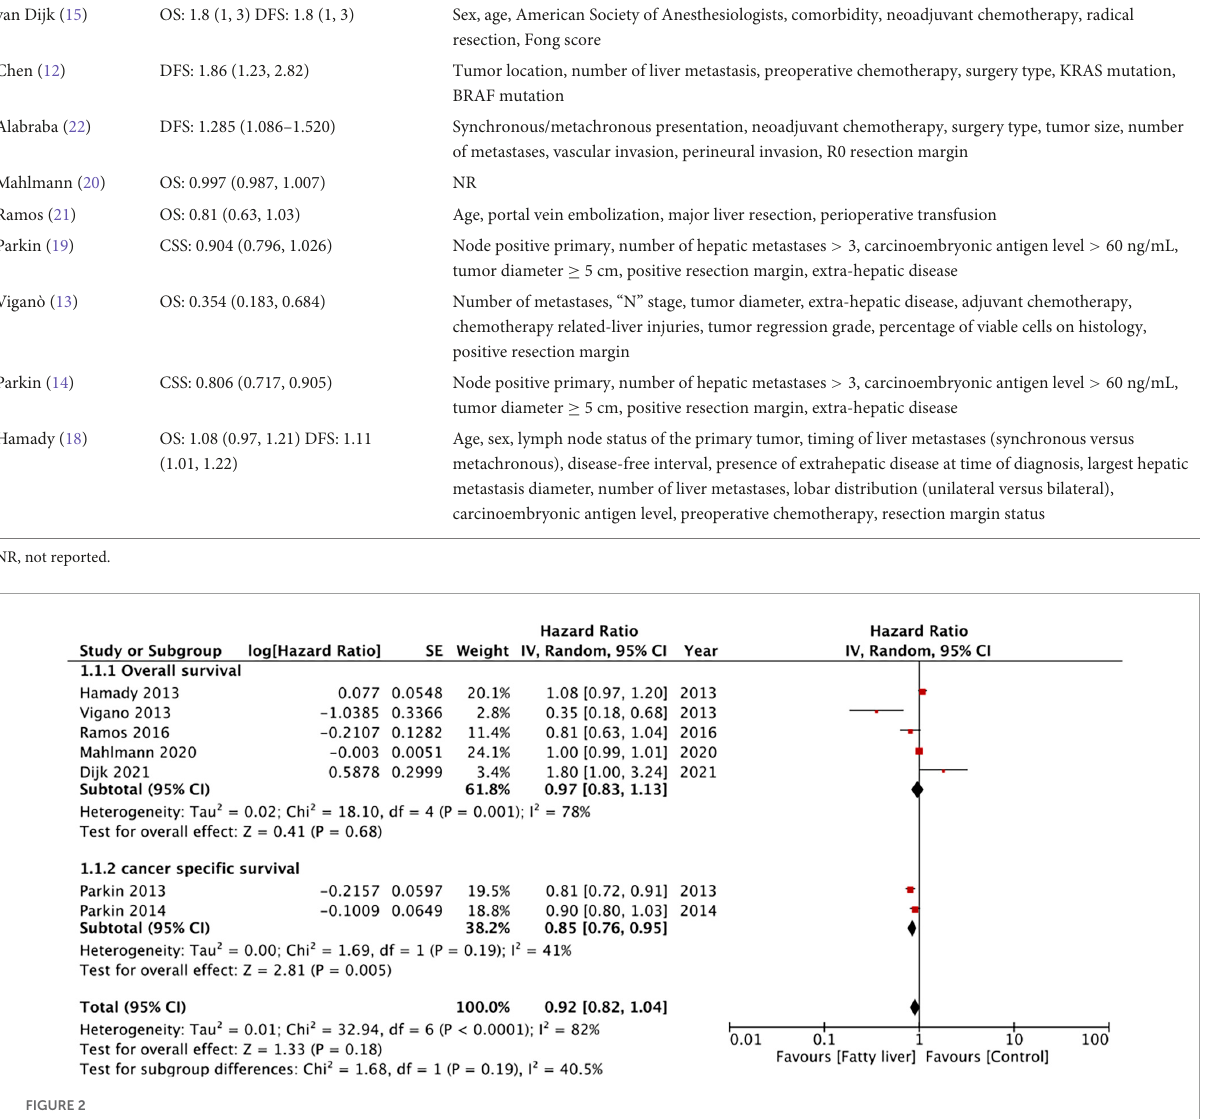
FIGURE2 Meta-analysis of the impact of hepatic steatosis on patient survival in